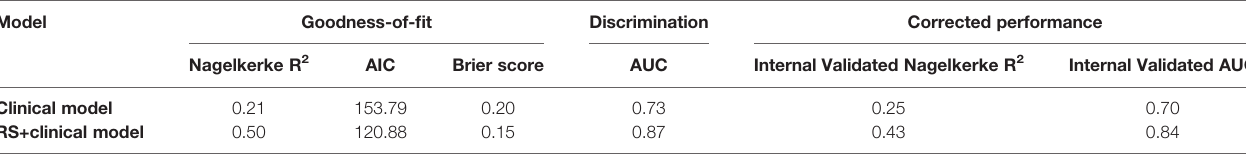
TABLE 3 | Performance of prediction models.